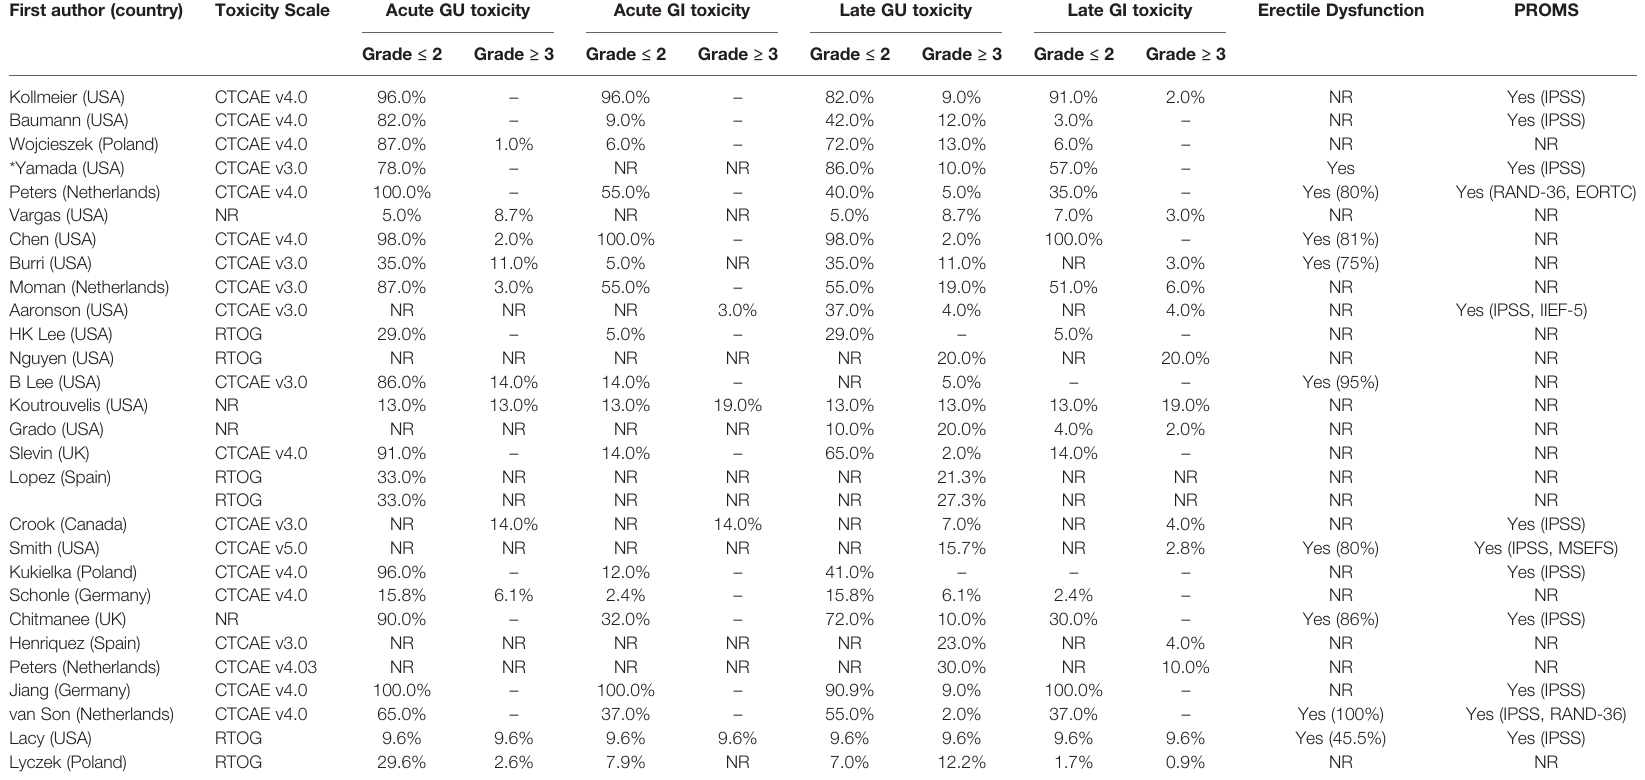
TABLE 8 | Toxicity details for BT